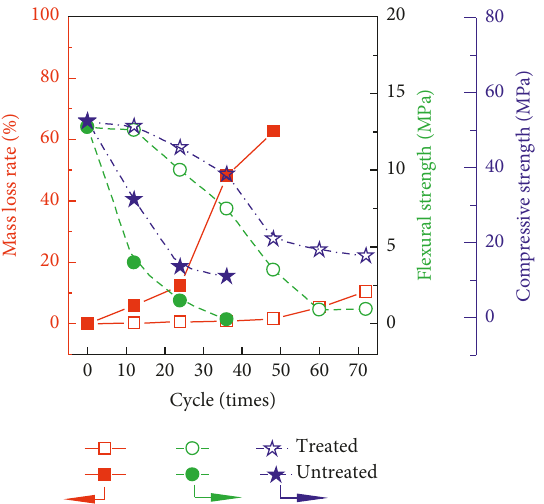
Figure 9: Mass loss rate